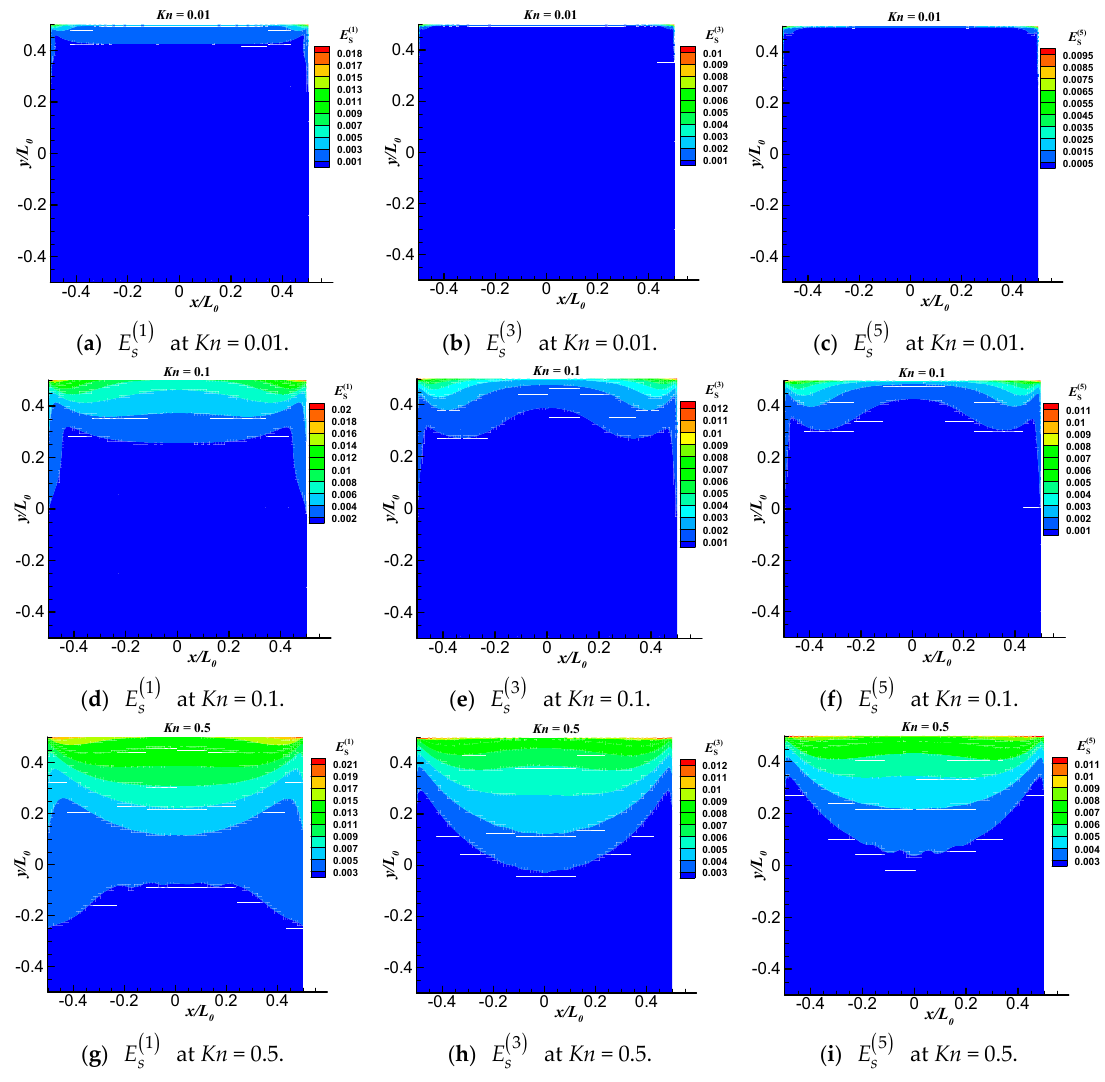
( 1 ) ( 3 ) ( 5 ) s , E s , E s at ( a – c ) Kn